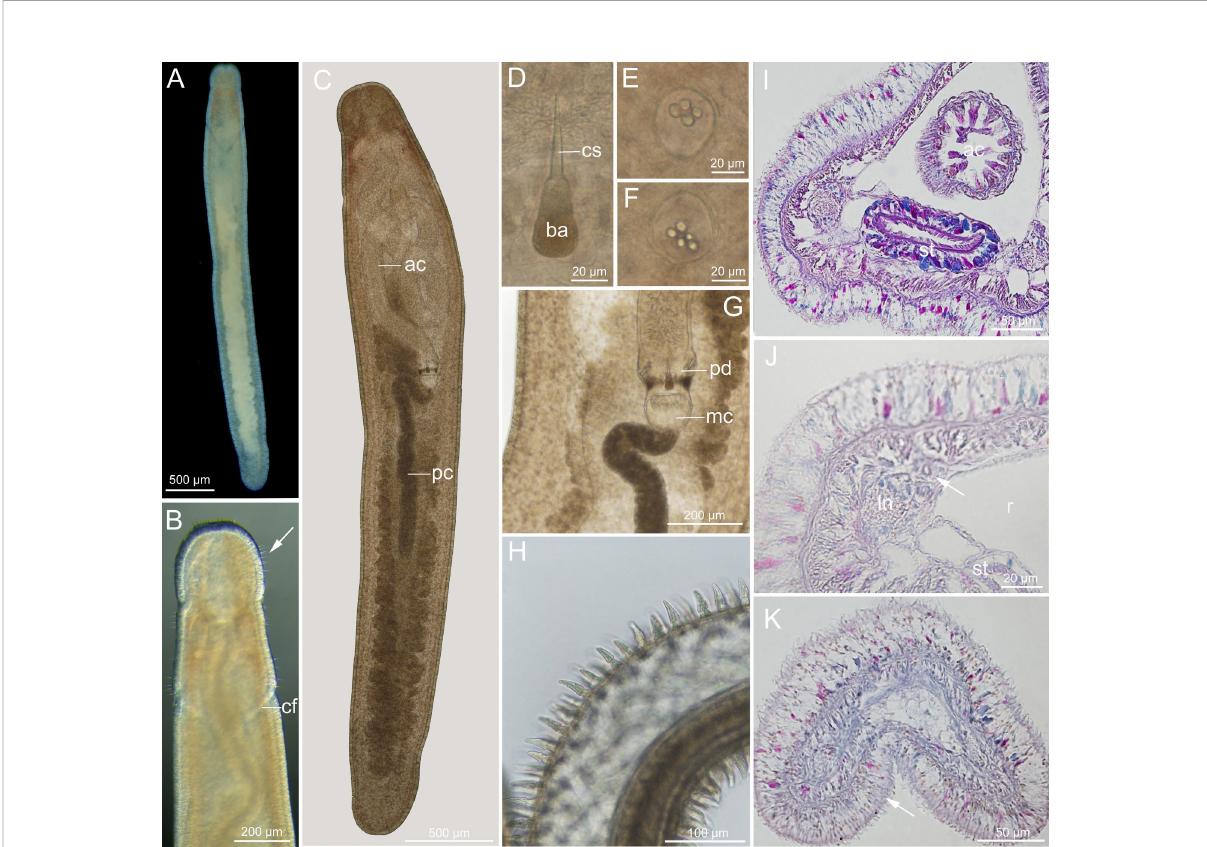
(Figure 3A). Cephalic furrows (posterior cephalic furrows; same below) posterior to brain (Figures 3A, B).